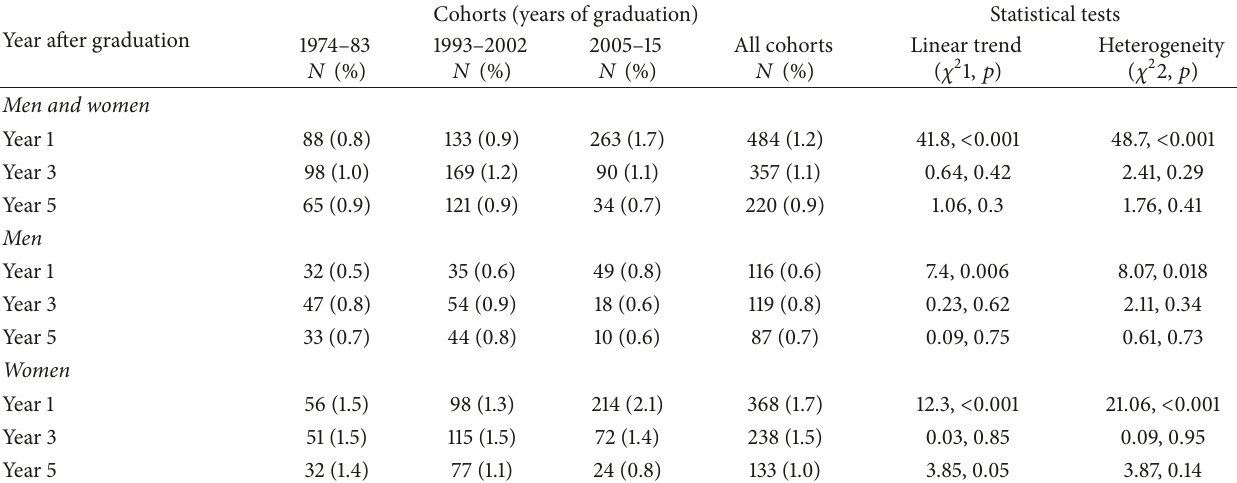
Table 1: Trends in early first choices for eventual career in dermatology: percentages of doctors who specified dermatology at years 1, 3, and 5 after